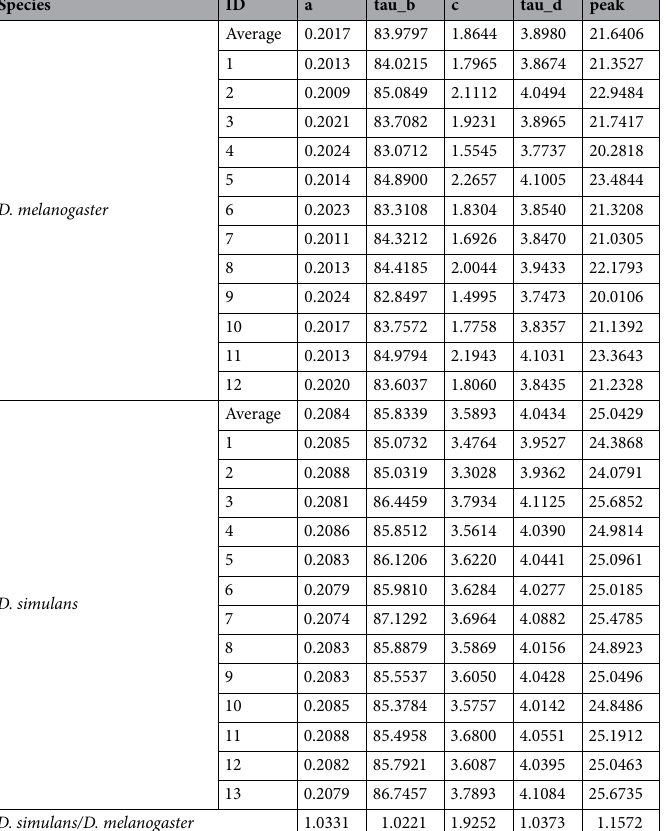
hereafter) between the species, the ∆responses only at 15-ms IPI were significantly lower in D. simulans than in D. melanogaster ( p = 0.01 at 15-ms, Fig. 4d) . This indicates that the decrease in response of AMMC-B1 neurons to short IPI stimuli in D. simulans is sharper than that in D. melanogaster. Notably, a difference in the IPFs of pulse songs had no significant effect on the IPI response properties of AMMC-B1 neurons ( p = 0.113 at 15 ms, p = 0.990 at 35 ms, Supplementary Fig. S4). In D. melanogaster , AMMC-B1 neurons receive both excitatory and inhibitory inputs (Supplementary Fig. S5) 31 . Inspired by this circuitry information, we fitted the normalized peak calcium responses of AMMC- B1 neurons to a function comprising two types of decay curves by using a hierarchical Bayesian model (Fig. 4e; Supplementary Fig. S4, see Supplementary methods). The fit function is described by y = ae − x /τ b − ce − x /τ d − x /τ − x /τ d , is deducted from another curve, ae b . The parameters a and c are the in which one decay curve, ce intercept values of each decay curve and τ b and τ d are the time constants of each exponential decay. We esti- mated the fitting function for each individual, and compared the estimated parameters and peaks between the species (Fig. 4f,g; Table 1). The fitting function faithfully recapitulated the actual values (Fig. 4e; Supplementary Fig. S4), and the estimated parameters were robust even when varying initial parameter values for fitting from 0.01 to 1 (data not shown). All the parameters in the fitting function were significantly larger in D. simulans than in D. melanogaster ( p = 3.85E−07 at a , p = 1.54E−06 at τ b , p = 3.85E−07 at c , p = 0.011 at τ d , Fig. 4f) . Of all tested parameters, parameter c yielded the largest interspecific differences between the two species ( D. simulans / D. melanogaster = ~ 1.925; Fig. 4f; Table 1). This result predicts that, at least in the range of parameter values estimated here, D. simulans AMMC-B1 receives a more profound reduction of neural responses to the short IPI song than D. melanogaster AMMC-B1 (Supplementary Fig. S5). The estimated peak IPIs (the IPI where the fit function showed peak responses) of these fit functions con- verged around 25-ms IPI in both species, but were slightly yet significantly larger in D. simulans than in D. melanogaster ( p = 3.85E−07, mean: 21.64 ms in D. melanogaster , 25.04 ms in D. simulans ; Fig. 4g). This implied